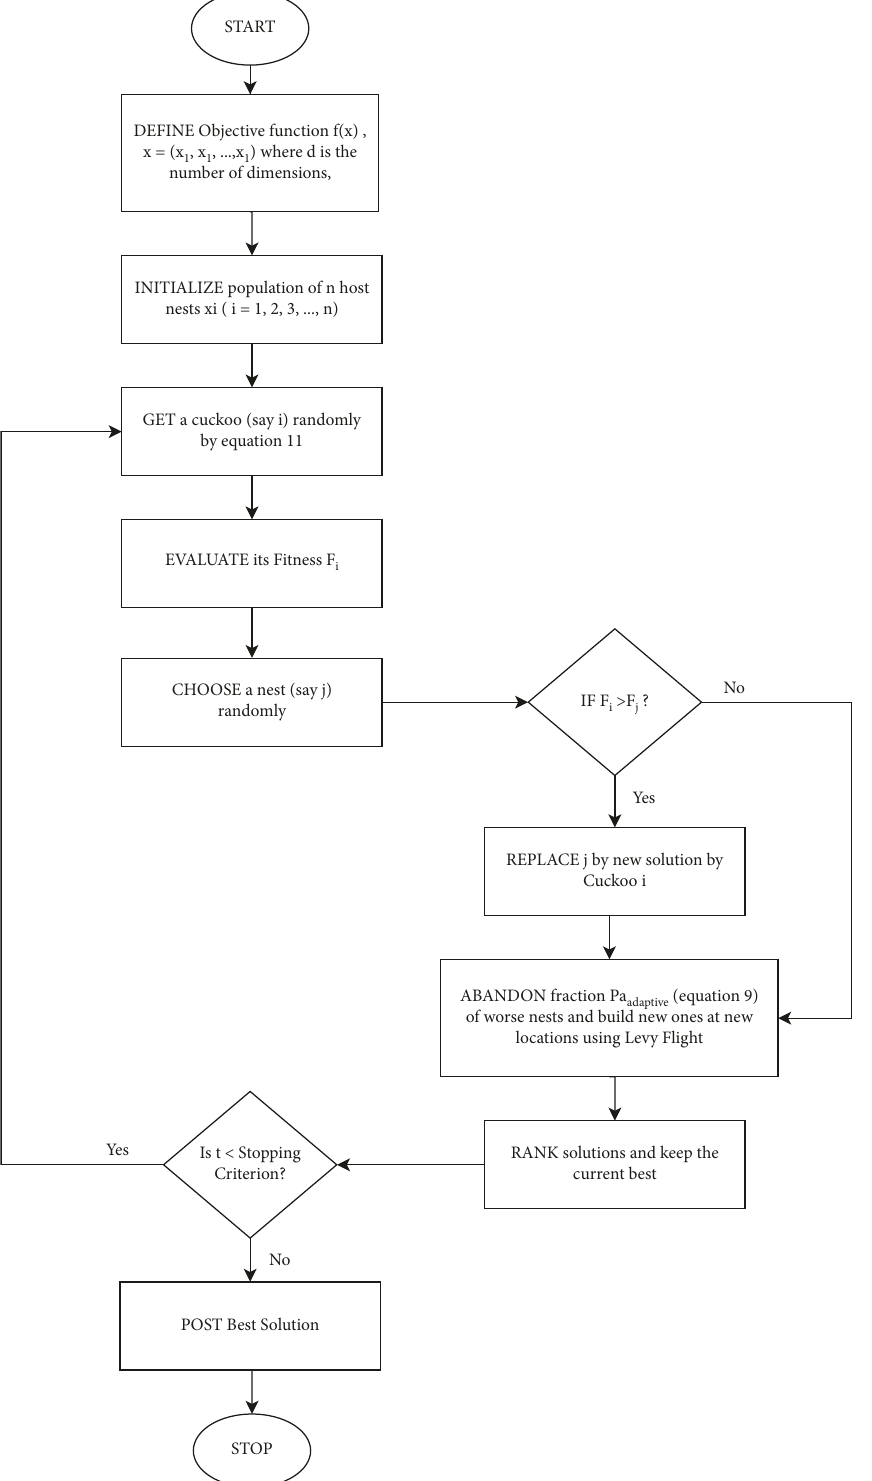
Figure 3: Flowchart representation of Algorithm